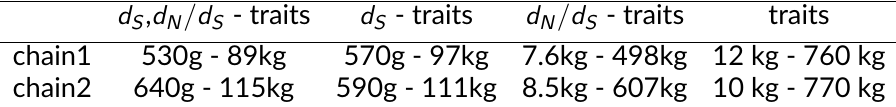
GC3-based ancestral